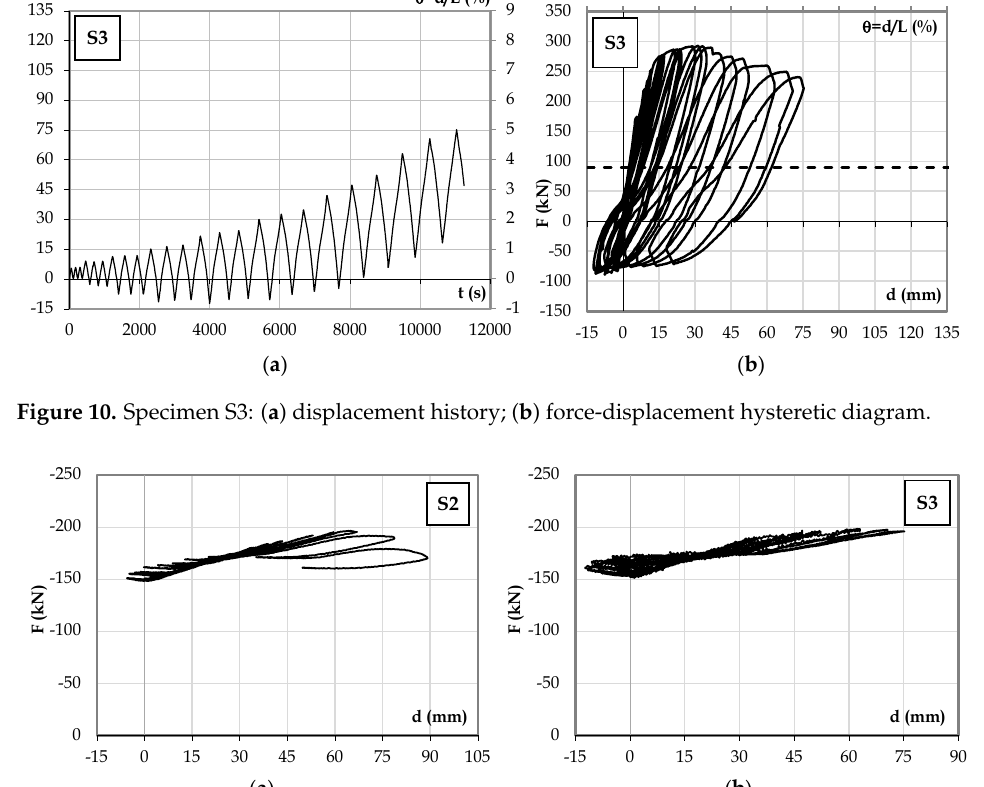
Figure 11. Diagram of post-tensioning force evolution versus imposed displacement: ( a ) Specimen S2 and ( b ) Specimen S3.